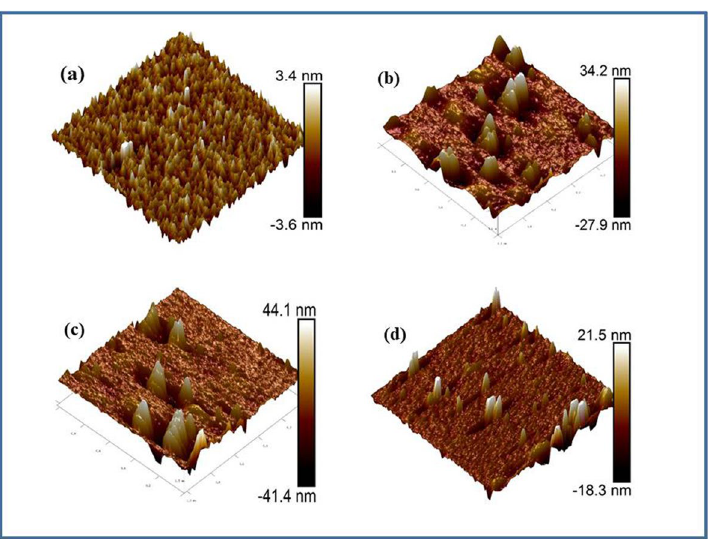
Figure 8. AFM micrograph of ( a ) virgin and 100 MeV 100 MeV Ni 7+ ion beam irradiated ZrO 2 thin films with varying fluence ( b ) 1 × 10 12 ions/cm 2 ( c ) 1 × 10 14 ions/cm 2 and ( d ) 2 × 10 14 ions/cm 2